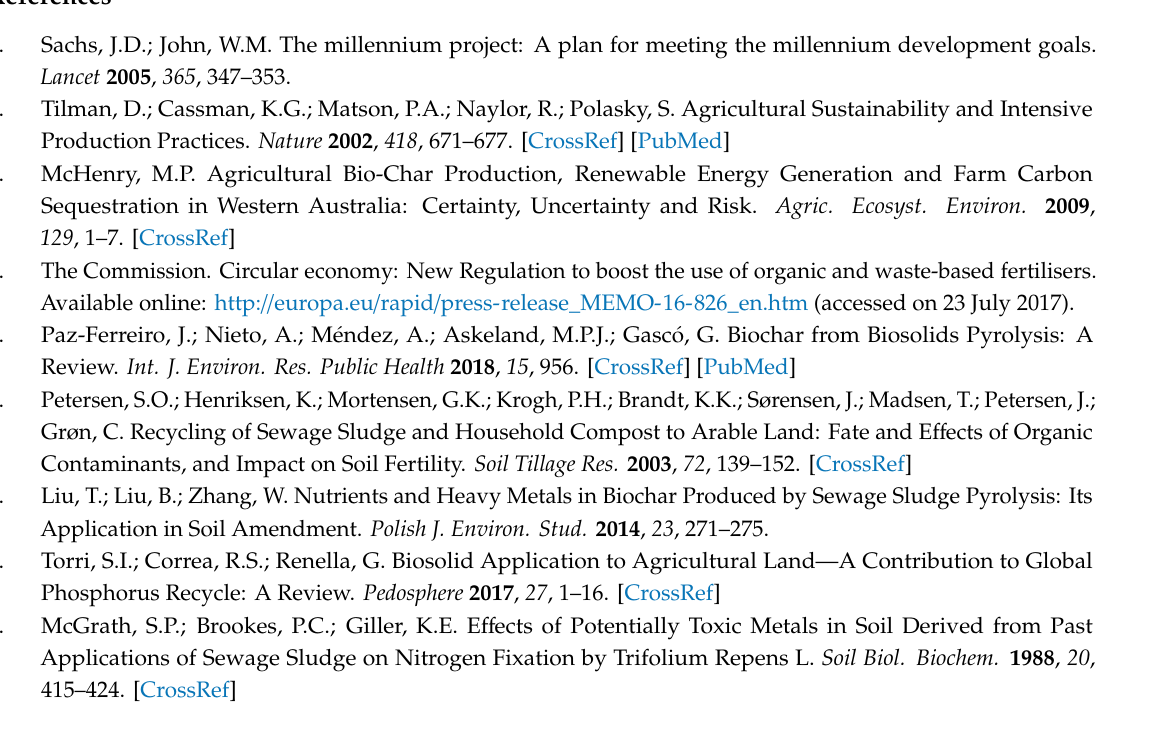
Table S1: Di ff erent proportions of sewage sludge and grape seeds used, Table S2: Characterization of the soil, Table S3: Percentage of e ffi ciency of elements (%) (averaged value ± standard error; n = 3 or 4), Table S4: Percentage of lixiviation of elements (%) (averaged value ± standard error; n = 3 or